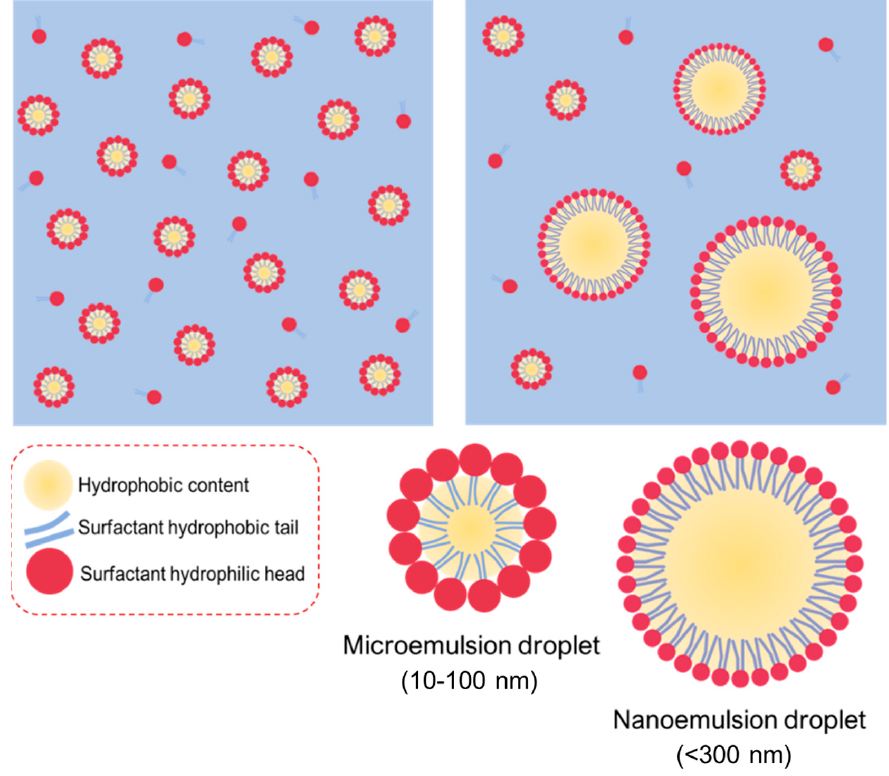
Figure 1. Illustration of microemulsions and nanoemulsions prepared from the similar elements of oil, water, and surfactant, giving the relatively similar structures with each other. Particle size is first used to differentiate microemulsions and nanoemulsions. The narrow and sharp peaks refer to microemulsions, whereas the broad or multi-peaks be- long to nanoemulsions, suggesting unstable thermodynamics during the nanoemulsion process [33]. Another method for identifying the microemulsions or nanoemulsions is to